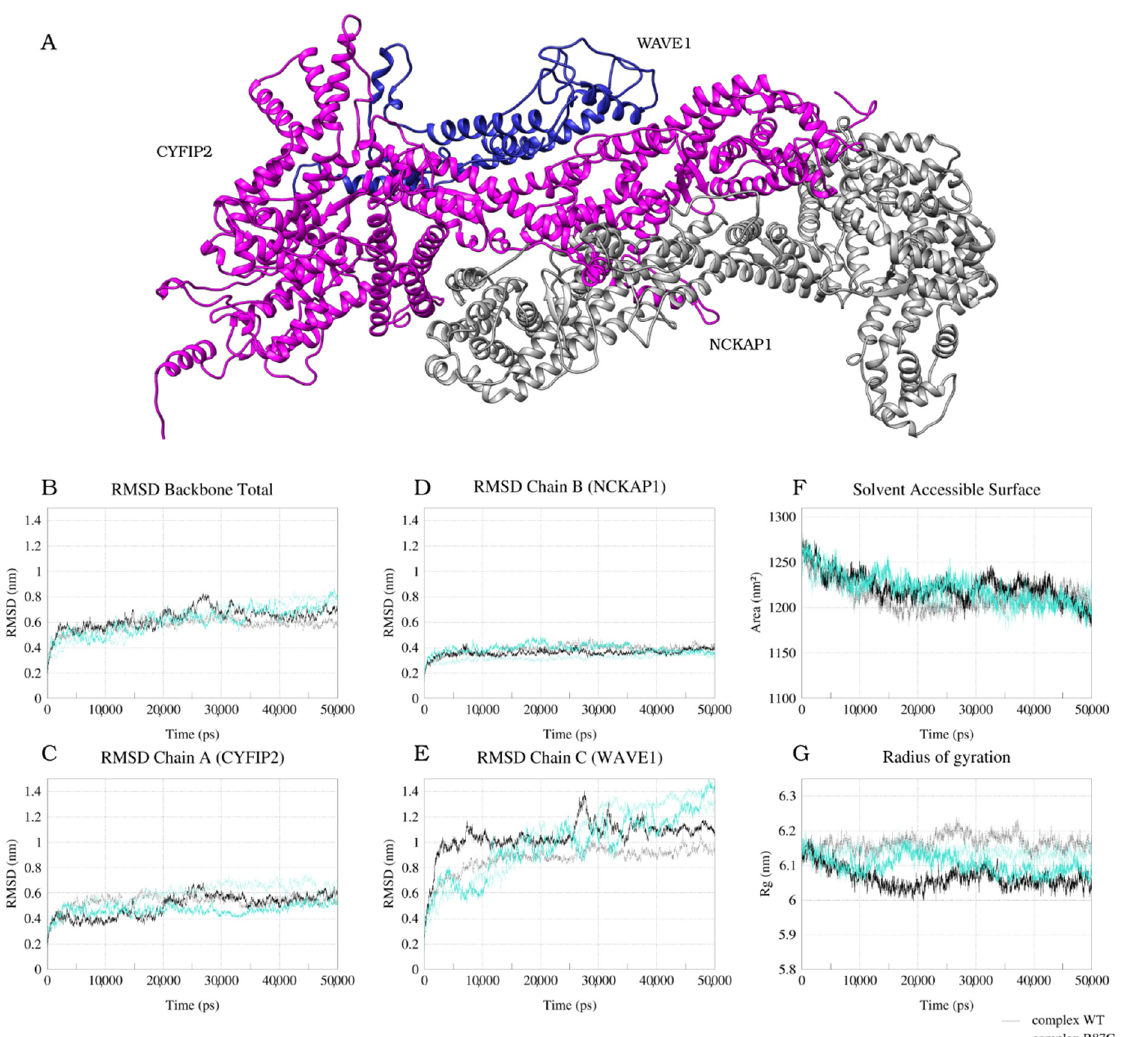
Figure 1. Structure and conformational evolution through the entire MD simulation of WT and R87C complex models. Ribbon representation of CYFIP2 (magenta), NCKAP1 (gray), and WAVE1 (blue) model ( A ). Plot of root-mean-square deviation (RMSD) calculated using the original model as a reference for the backbone of all chains ( B ), CYFIP2 chain ( C ), NCKAP1 chain ( D ), and WAVE1 chain ( E ). Plot of solvent-accessible surface area (SASA) ( F ). Plot of the radius of gyration (Rg) ( G ). Data for complex WT simulation are represented by dark (first replica) and light (second replica) gray lines. Data for complex R87C simulation are represented by dark (first replica) and light (second replica) cyan lines.